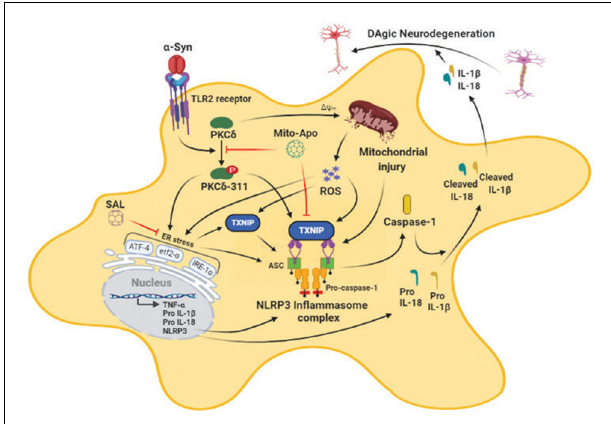
FIGURE 10 | Schematic representation of the role of mitoROS-PKC δ -mediated endoplasmic reticulum stress (ERS)-dependent induction of the TXNIP/NLRP3 signaling axis in response to the α Syn agg -induced reactive microglial activation state. The treatment of microglial cells with α Syn agg triggers mitoROS and PKC δ activation resulting in ERS-dependent activation of proinflamamtory signaling events including the TXNIP/NLRP3 activation response. Both mitochondria-driven oxidative stress and PKC δ activation contribute to the α Syn agg -induced reactive microglial activation state via ERS through a feed-forward mechanism. An association between TXNIP and NLRP3 may partly explain the NLRP3 inflammasome-associated innate immune response. Moreover, α Syn agg -induced microglial ERS causes indirect DAergic neurotoxicity. Importantly, Mitoapo and PKC δ -silencing suppress ERS and the associated TXNIP/NLRP3 signaling axis in response to α Syn agg , thereby attenuating the reactive microglial activation state. Finally, salubrinal (SAL) attenuated the indirect DAergic neurotoxicity elicited by α Syn agg , further highlighting the pivotal role of ERS in the expression of a neurodegenerative microglial phenotype and associated DAergic